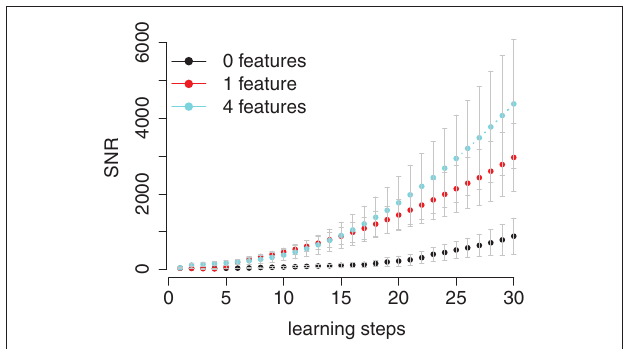
Figure 4 | Signal-to-noise ratio (SNr) as a function of learning step and initial overlap in the pool of Sius. Each plotted point contains data from five random networks and five repetitions with each network/overlap condition. The error-bars show the Standard Error of the